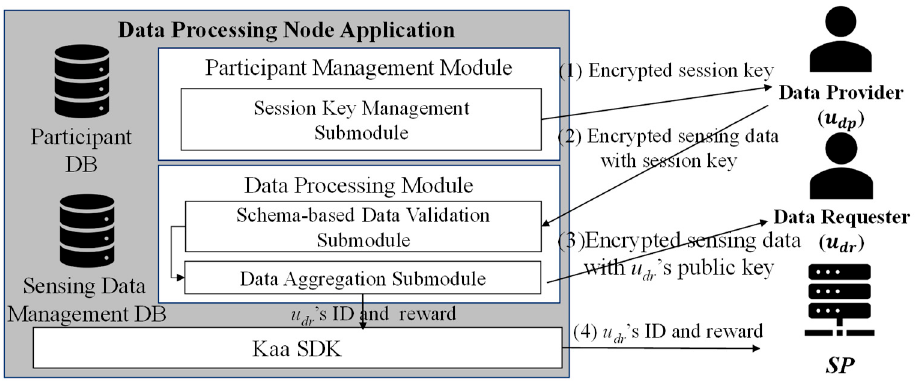
Figure 10. Application structure of data processing node.